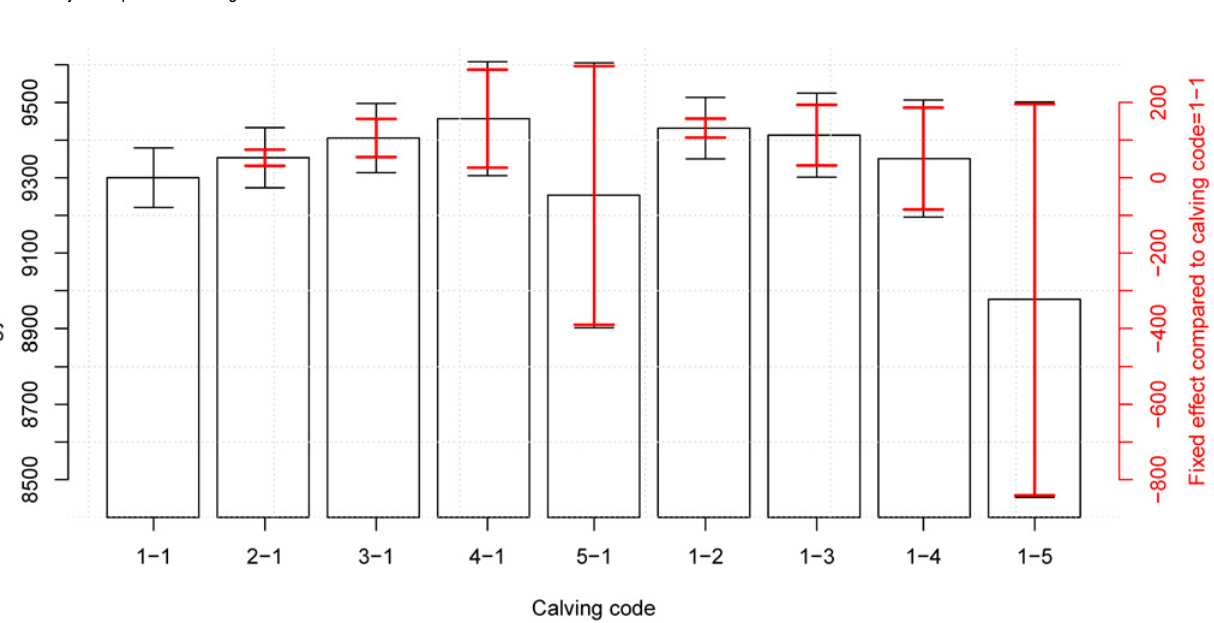
Fig 5. Effect of calving difficulty on milk production in the second lactation period. When using the best model (Eq 2) including yearly, seasonal, calving, and herd effects there is a significant difference of 131.6 ECM ( sd = 12.90) and 113.0 ECM ( sd = 41.09) between having an easy calving in both parities (calving code = 1-1) and more difficult calvings in parity 2 (calving codes = 1-2 and 1-3) (red CI). When including the variance of the reference level there is still significant difference on the total energy corrected milk production (black CI) for calving code 1-2. There is also a significant difference of 53.02, 105.4, and 156.7 ECM ( sd = 10.97, 25.80, 66.46) between having an easy calving in both parities (calving code = 1-1) and more difficult calvings in the first parity (calving codes = 2-1, 3-1, and 4-1 respectively) (red CI). When including the variance of the reference level there is still significant difference on the total energy corrected milk production (black CI) for calving code 3-1. The numerical results are available in Table 6.